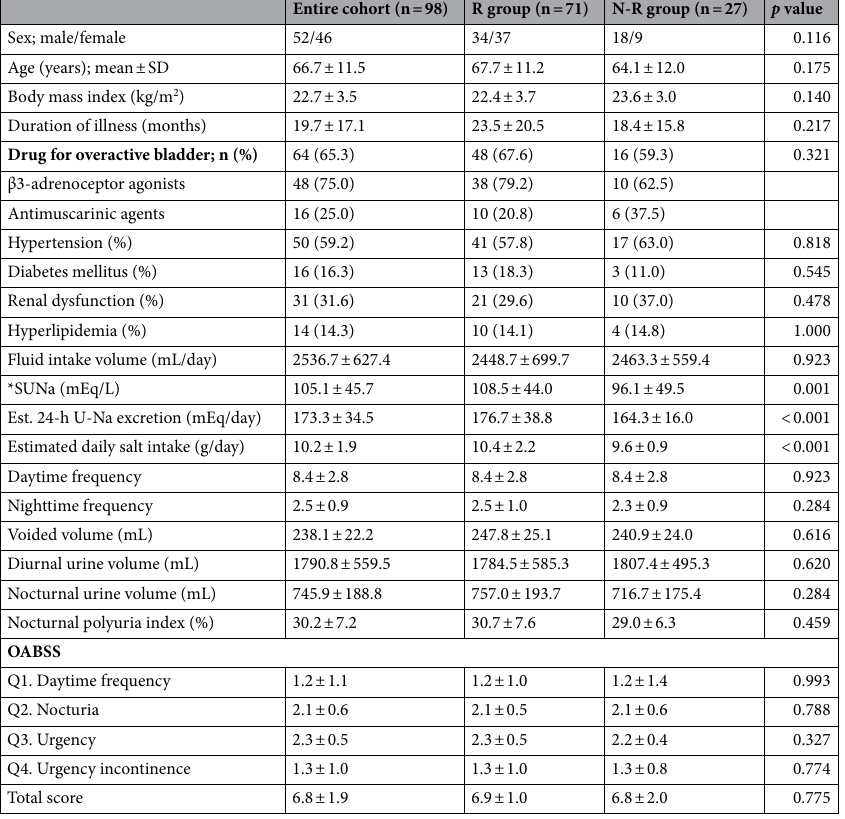
Table 1. Patients’ characteristics and urological symptoms before salt intake reduction in each group. R group restricted group, N-R group non-restricted group, SUNa Na concentration in the spot urine, Est. 24-h